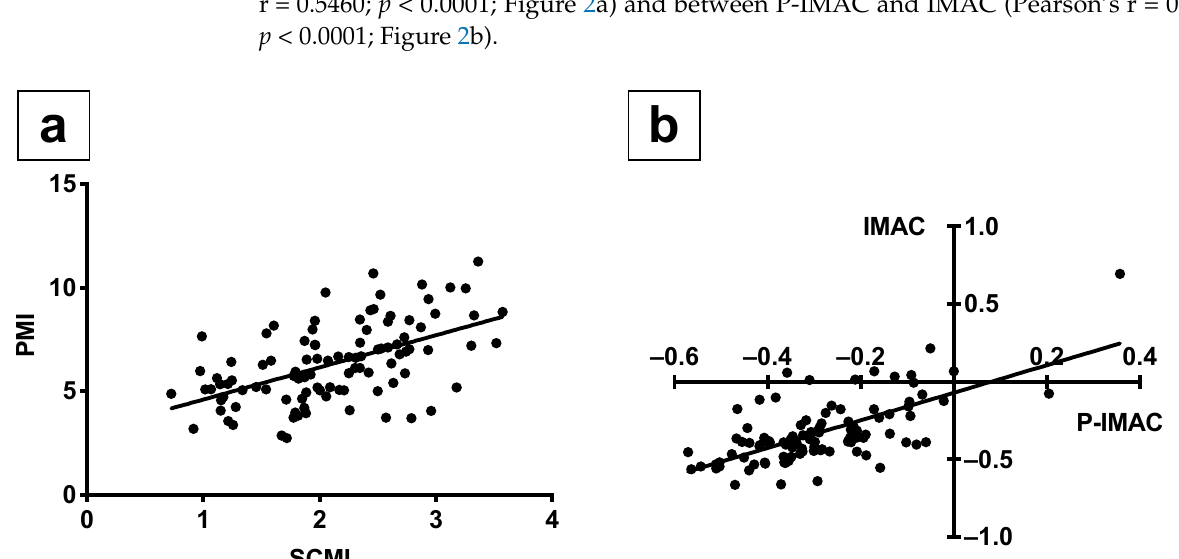
Figure 2. The positive correlations between SCMI and PMI, as well as P-IMAC and IMAC. ( a ) SCMI was correlated well with PMI (Pearson’s r = 0.5460; p < 0.0001): ( b ) P-IMAC correlated well with IMAC (Pearson’s r = 0.6689; p < 0.0001). SCMI, sternocleidomastoid muscle mass index; PMI, psoas muscle mass index; P-IMAC, processus spinosus muscle—intramuscular adipose tissue content; IMAC, intramuscular adipose tissue content.